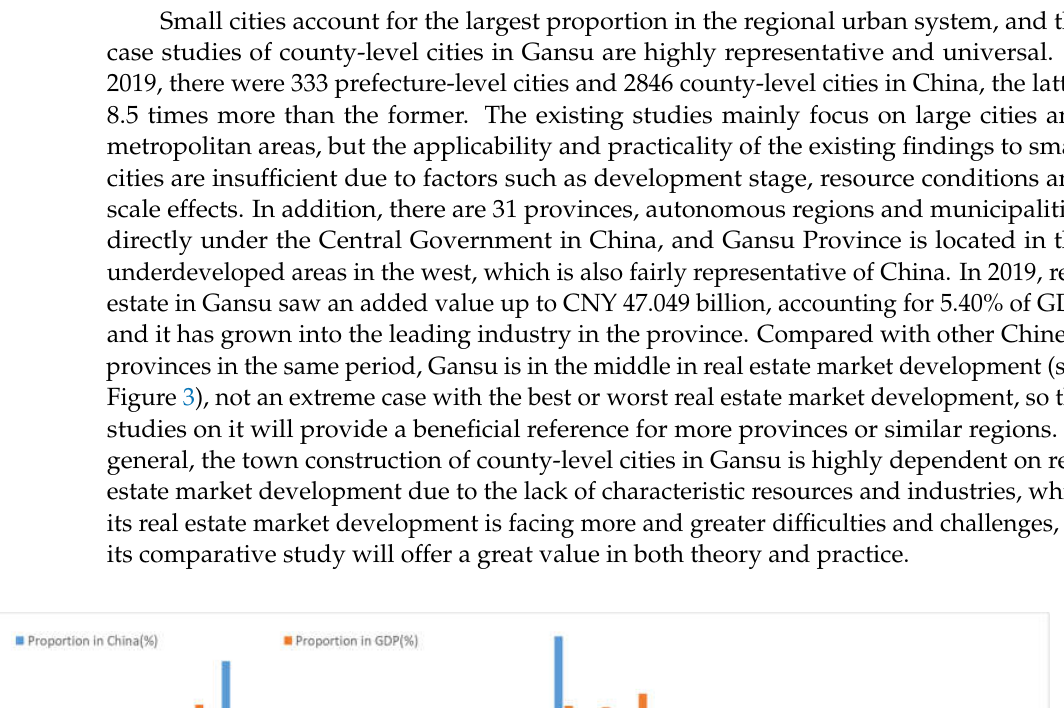
Figure 2. Evolution of real estate market in Gansu Province.